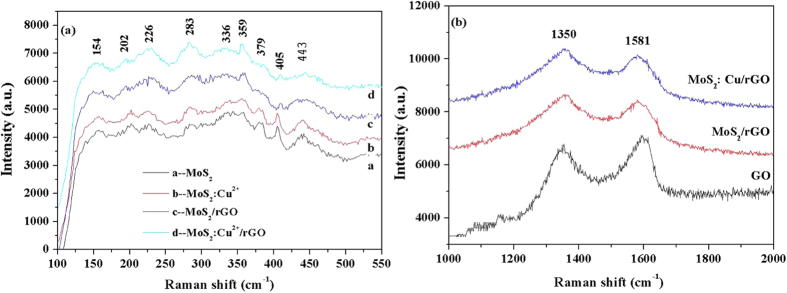
Raman spectra in Raman shift range of (a) 100–550 cm−1 and (b) 1000–2000 cm−1.